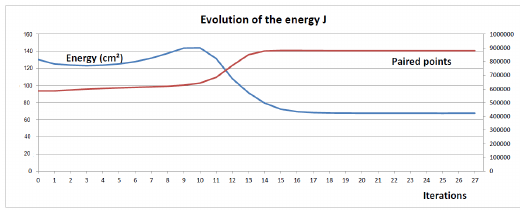
Figure 13: Evolution of the energy for real point cloud #3